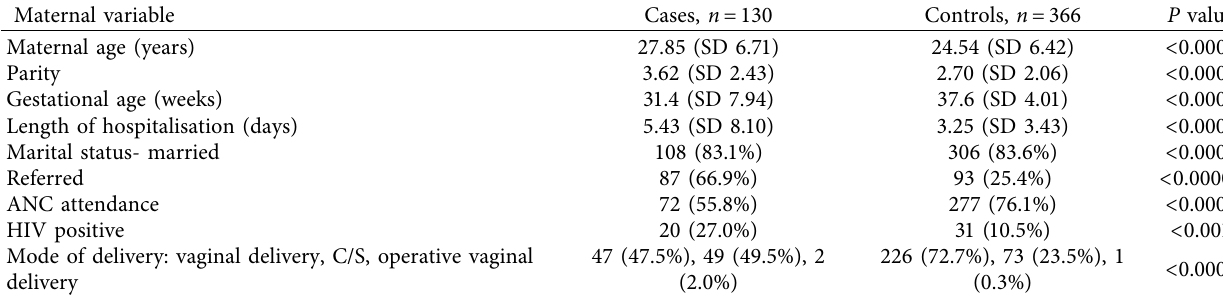
Table 1: Maternal characteristics of cases and